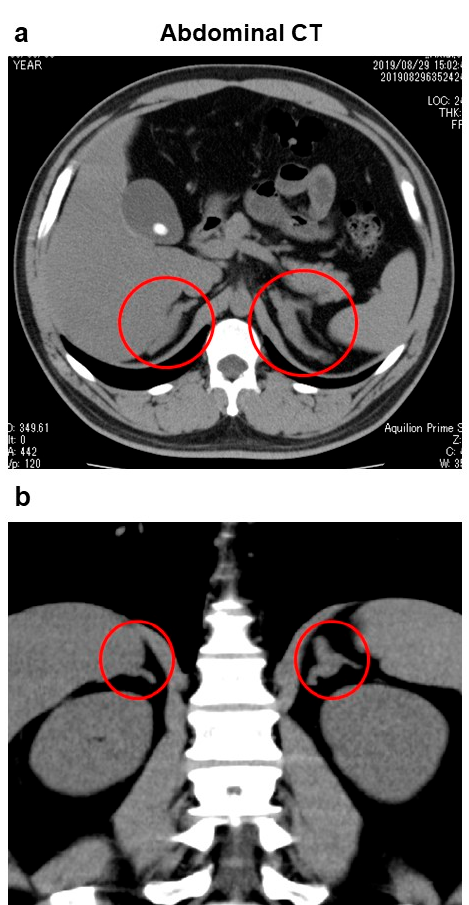
Figure 1. Abdominal computed tomography: ( a ) cross-sectional image, and ( b ) longitudinal image. Swelling was observed in bilateral adrenal glands, although morphology was normal (circles), suggesting the presence of adrenal hyperplasia. In addition, fatty liver, gallbladder stones and a right renal cyst were observed. There were no enlarged lymph nodes and no findings suggesting malig- nancy.